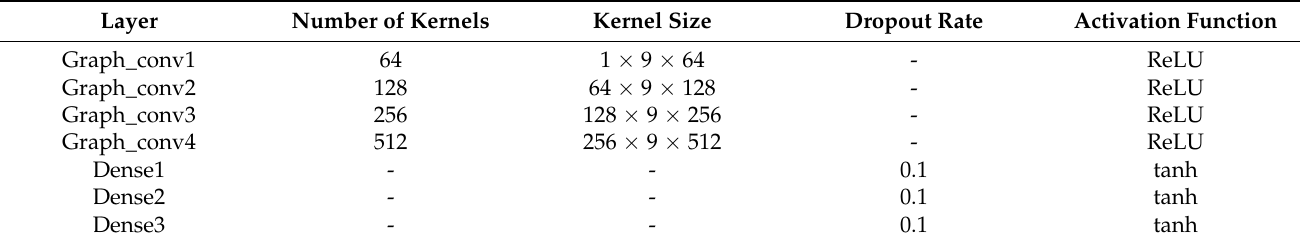
Table 2. Details of the architecture of the proposed